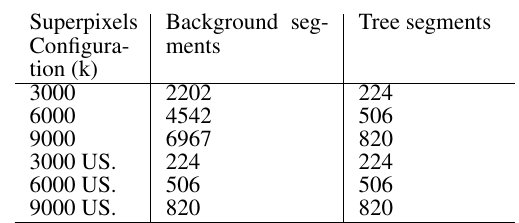
Table 2. Dataset used with classes Background and